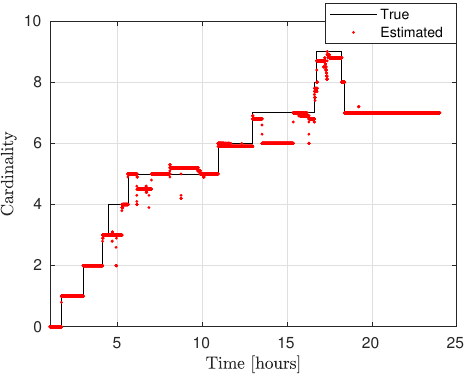
Figure 5. SO average cardinality for the MC experiments at each time step. The black curve shows the ground-truth and the red curve, the estimated